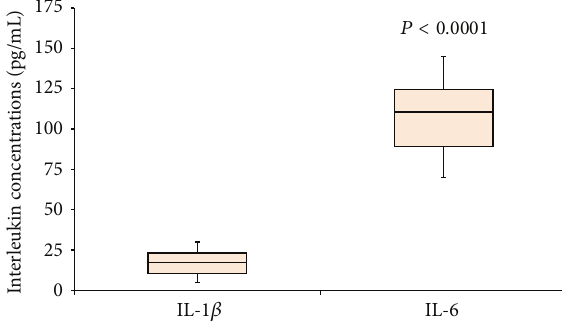
Figure 1: Levels of IL-1 𝛽 and IL-6 in H1N1 patients are shown in the figure. Box plot representation was used. The level of IL-6 was significantly higher than the level of IL-1 𝛽 ( 𝑃 < 0.0001 ).